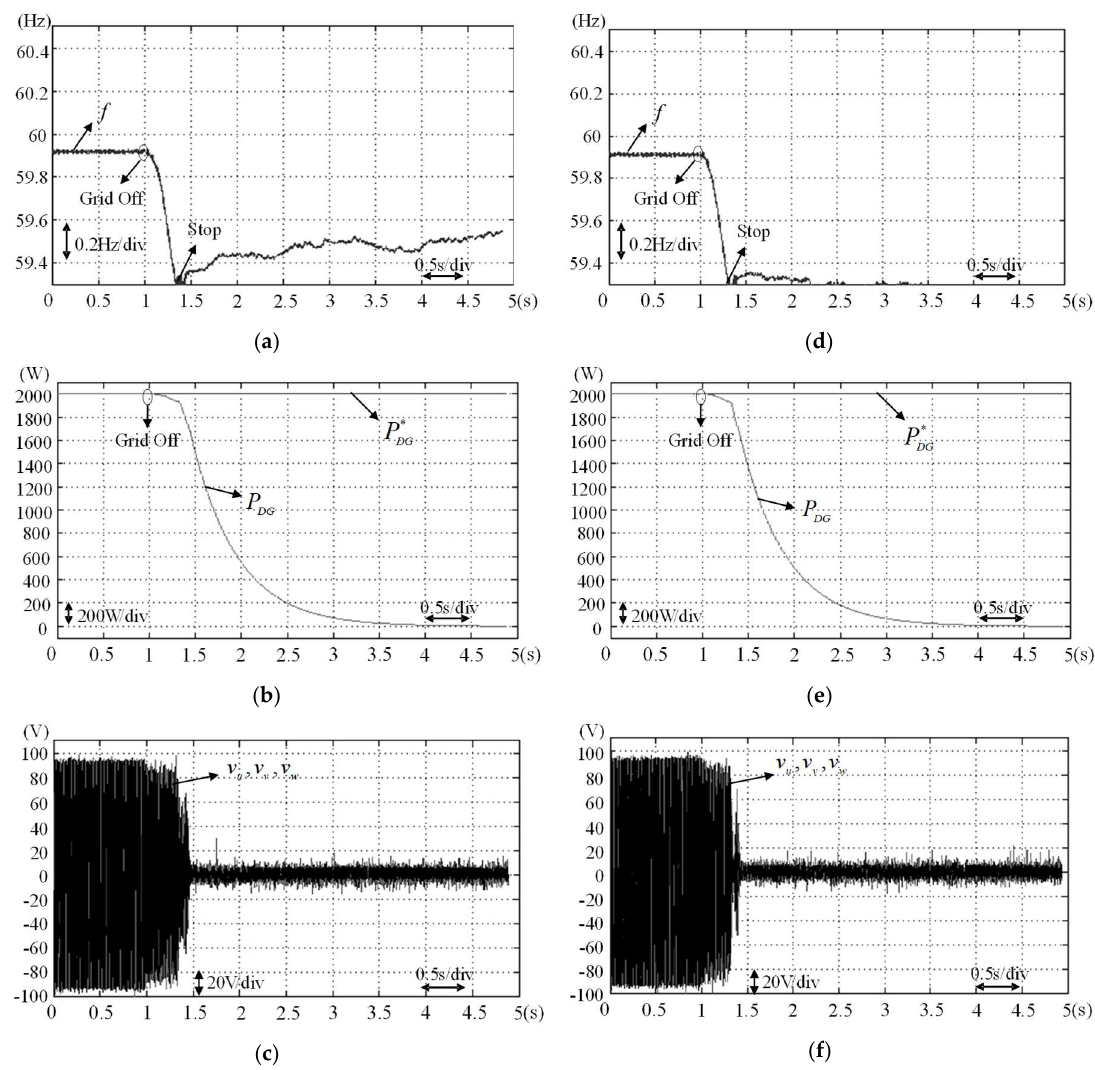
Figure 9. Experimental results of proposed active islanding detection method at case 2: ( a ) Frequency response using PI controllers; ( b ) Responses of active power output using PI controllers; ( c ) Voltage response using PI controllers; ( d ) Frequency response using adopted PFNN controllers; ( e ) Responses of active power output using adopted PFNN controllers; ( f ) Voltage response using adopted PFNN controllers.